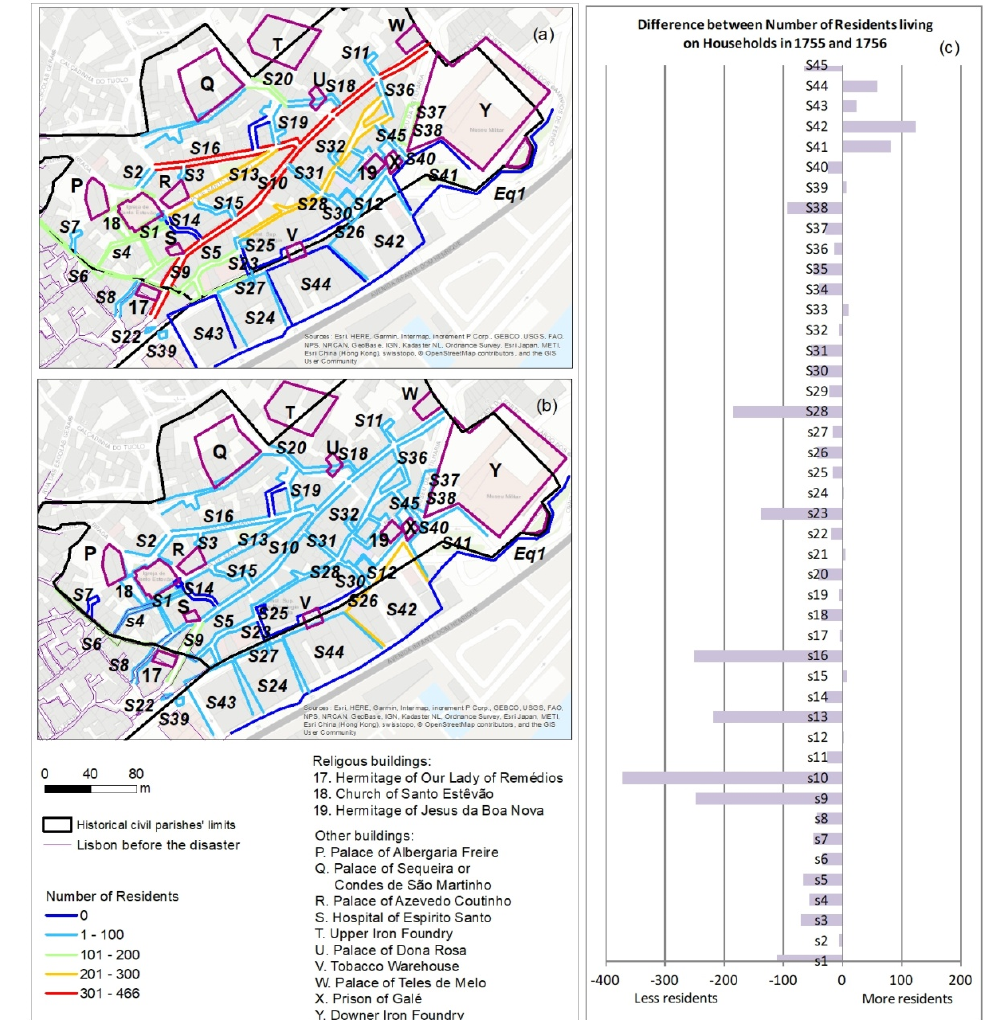
Figure 5. Number of residents living in households in the historical civil parish of Santo Estevão: ( a ) 1755; ( b ) 1756; ( c ) Difference in the number of residents. List of street names, land uses and equip- ment are indicated in Figure 4. The present-day layout of the city is presented on the background.